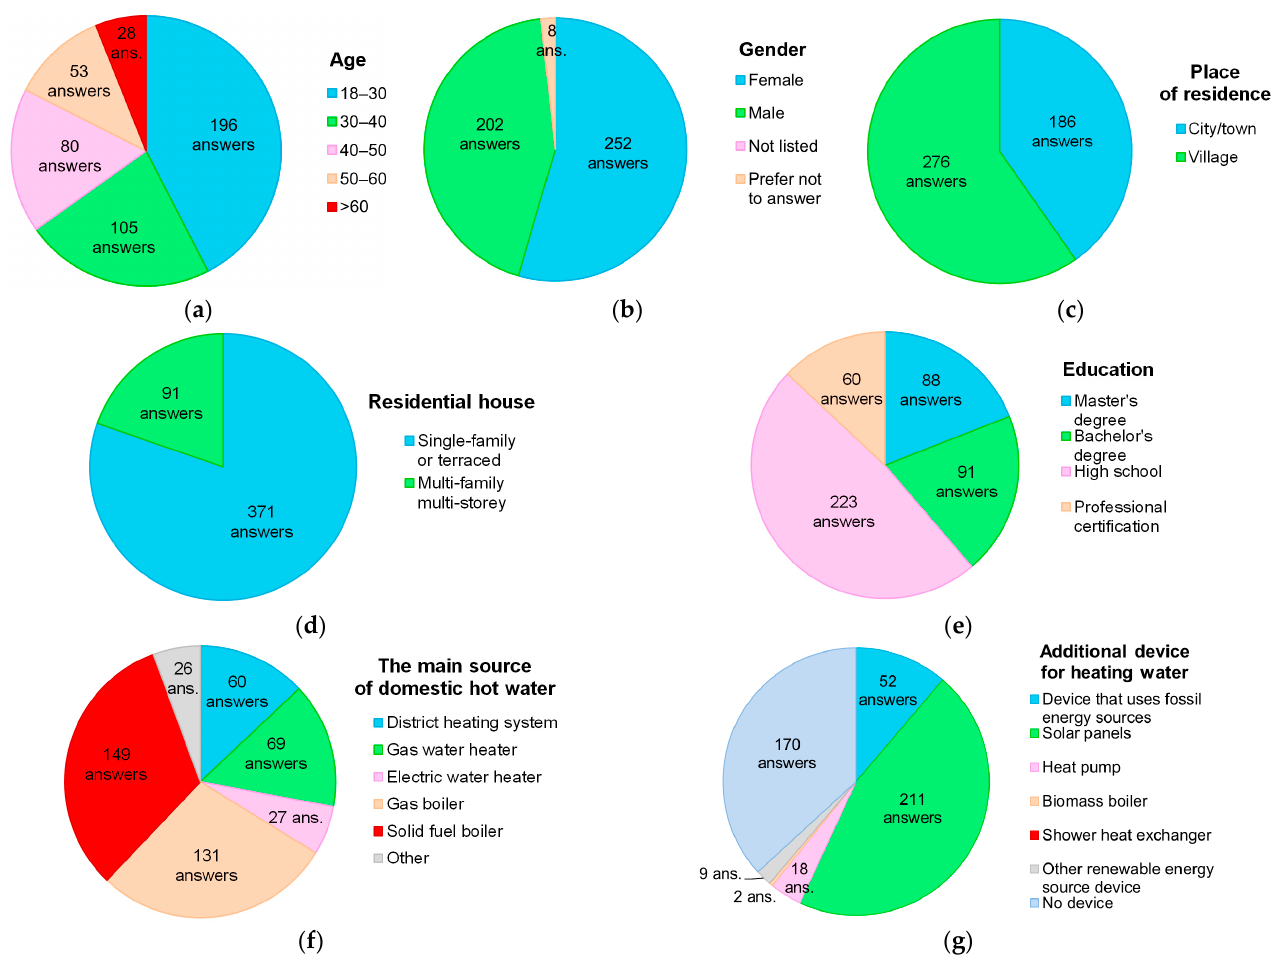
Figure 6. Characteristics of the respondents and their water heating systems: ( a ) Age; ( b ) Gender; ( c ) Place of residence; ( d ) Residential house; ( e ) Education; ( f ) The main source of domestic hot water; ( g ) Additional device for heating water.